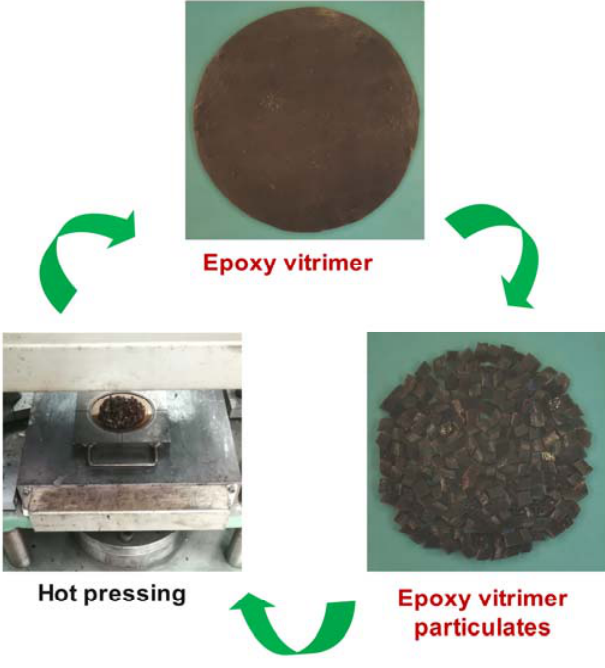
Figure 2. Schematic illustration for the recycling of vitrimer.